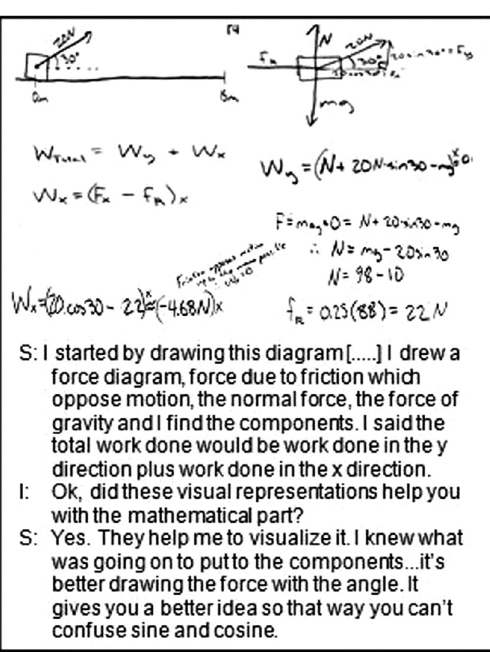
FIG. 23. Solve value from linguistic representation (question 9).